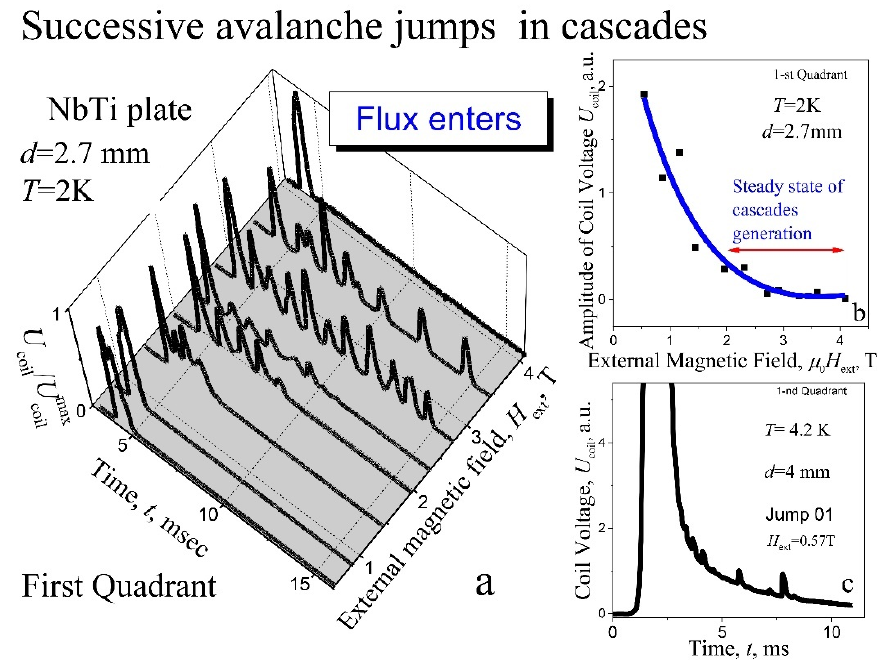
Figure 4. ( a ) Evolution of the normalized voltage impulses structure U coil ( t )/ U max coil at the avalanche during the increase of magnetic field; ( b ) the amplitude of voltage impulse vs magnetic field and exponential fitting to the experimental data: d = 2.7 mm, T = 2 K; ( c ) the voltage impulse at first flux jump: T = 4.2 K, µ 0 H ext = 0.57 T, d = 4 mm. Screening regime; ZFC.